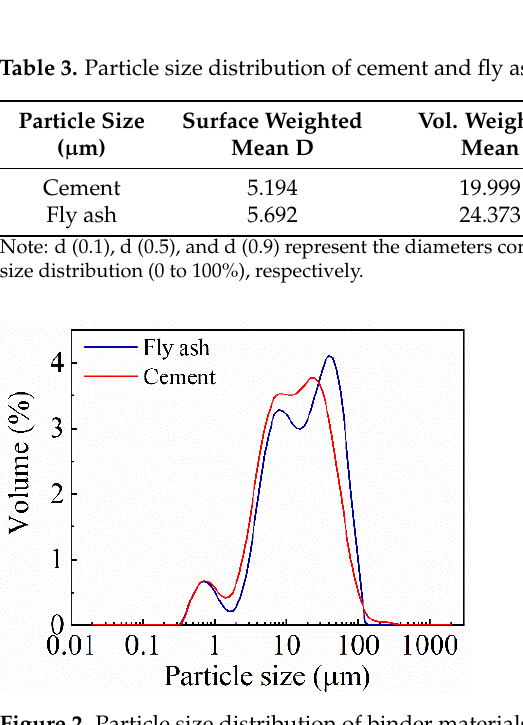
1.01 Table 3. Particle size distribution of cement and fly ash.